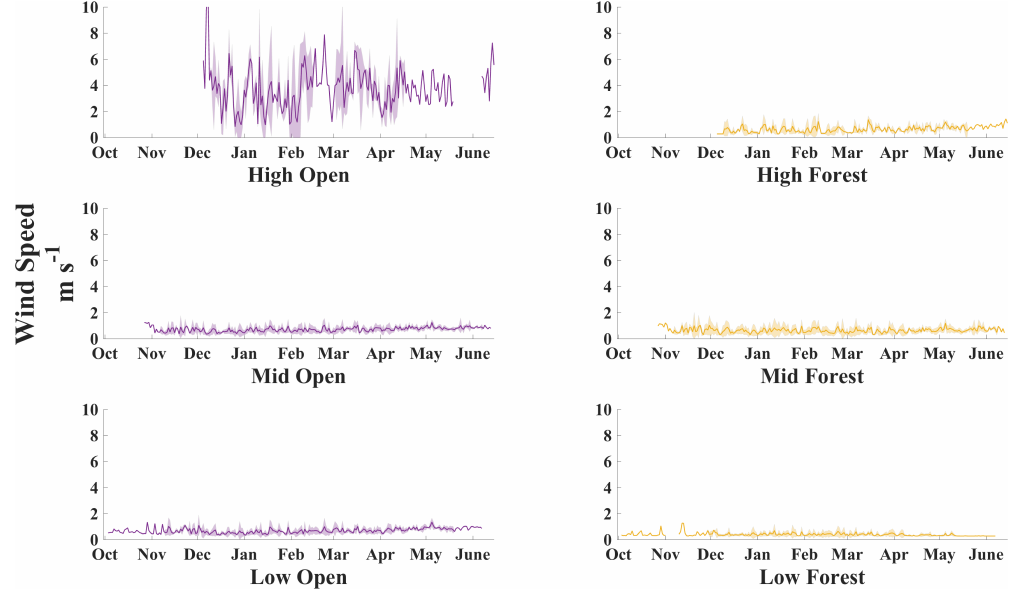
Figure 7. Daily average wind speed (heavy solid line) and the range of wind speeds (shaded area) for each site within the ForEST network, WY 2012–WY